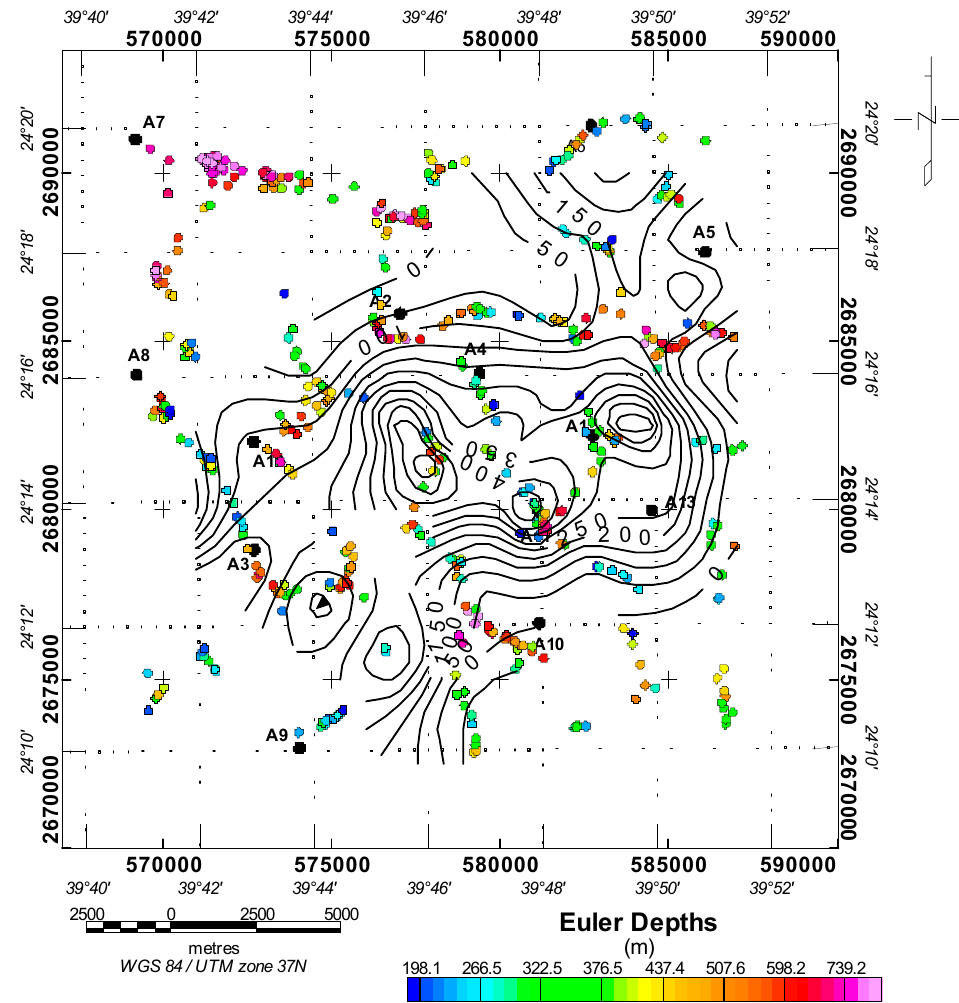
Figure 14. A comparison of the basement depth (m) estimates between the Euler deconvolution and PSO-derived depths. The Euler depths range between 135–695 m within the anomalous region of the study area.